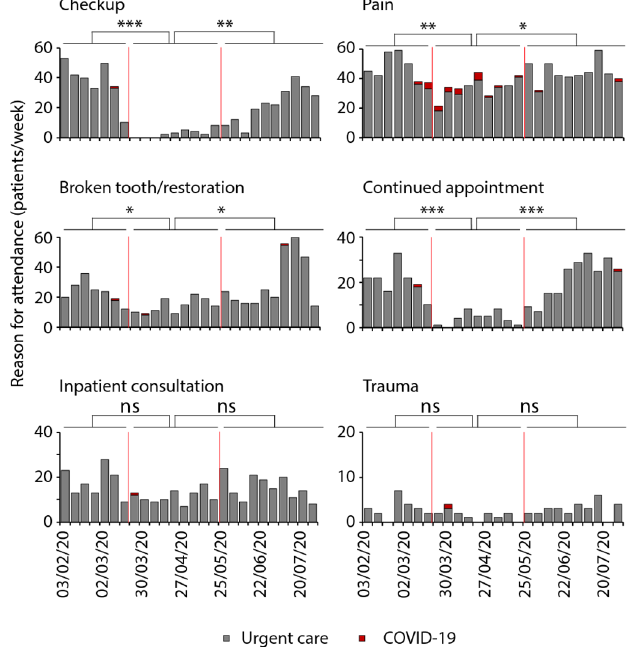
Figure 3. Reasons for seeking urgent dental care during the initial period of the COVID-19 pandemic. Patients´ reasons for attending the urgent dental care unit were categorized into checkup with minor questions (n = 507), pain (n = 1079), broken tooth/restauration (n = 588), continued appointment (n = 395), inpatient consultation (n = 381), and trauma (n = 64) from 3 February to 31 July 2020. The first red line marks the beginning and the second marks the end of the national lockdown, dividing the time into pre-lockdown, lockdown, and post-lockdown. The red bars represent patients with high- risk of or confirmed COVID-19 infection (ANOVA; * p ≤ 0.05, ** p ≤ 0.01, *** p ≤